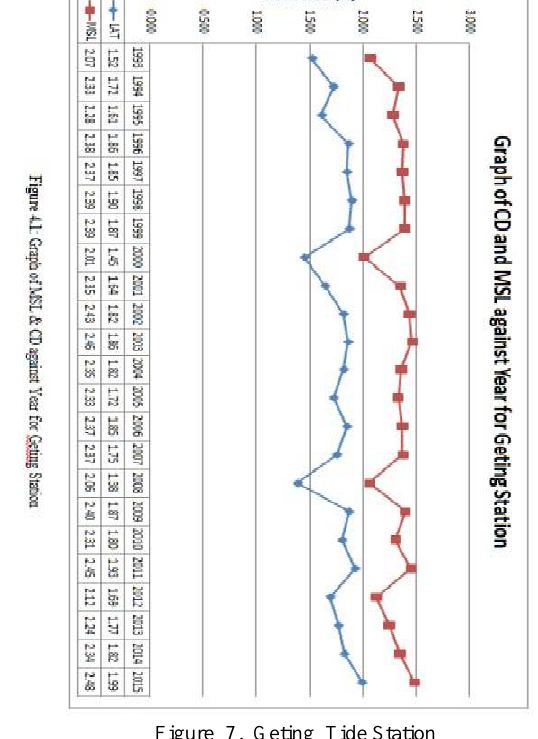
Figure 7. Geting Tide